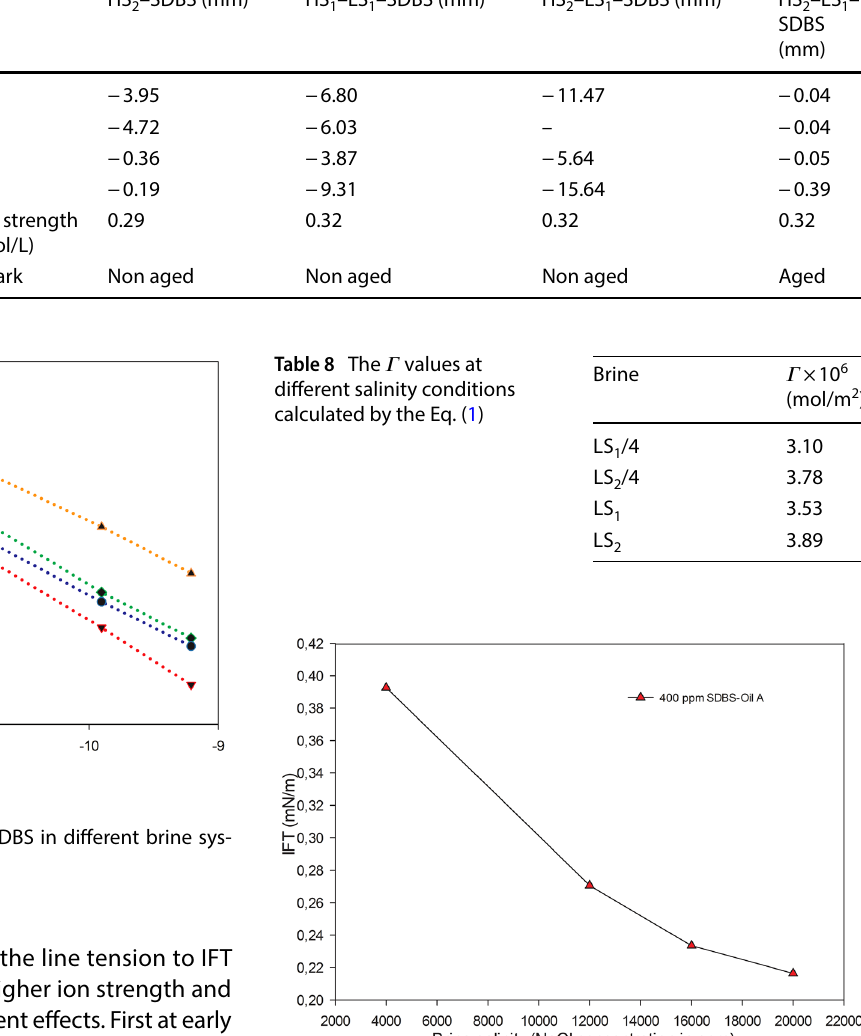
Table 7 Line tension to IFT ratios for four crude oils and different surfactant systems